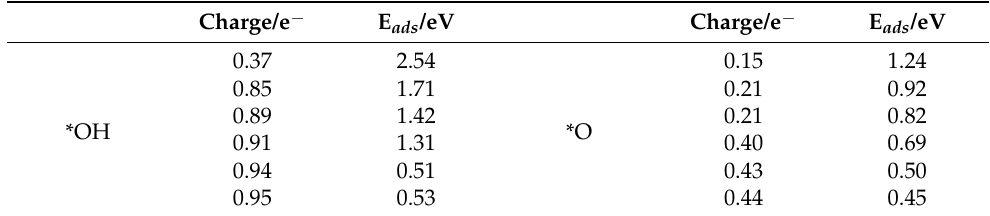
Table 1. The amount of charge transfer of OH or O after adsorption, along with adsorption energies for nickel phosphide.